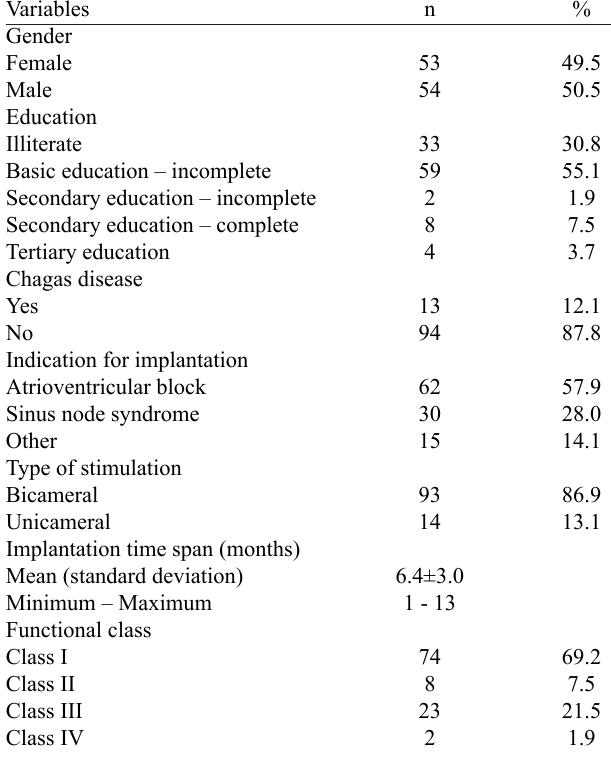
Table 1. General and clinical characteristics of the 107 patients included in the study.